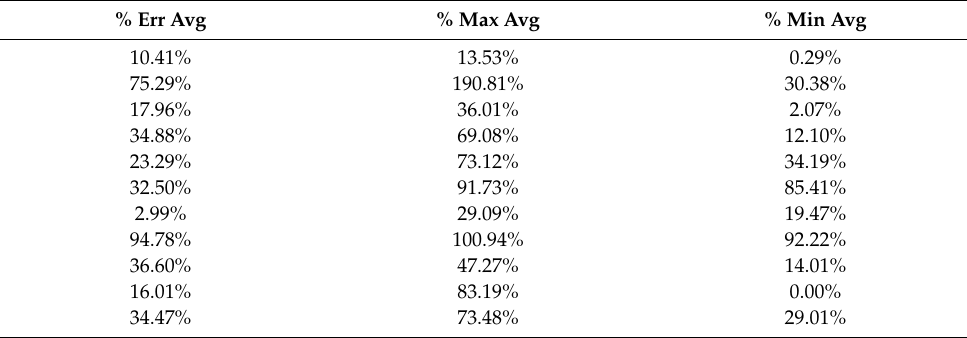
Table A150. Set 2, trials 41–50 data (actual PR value).